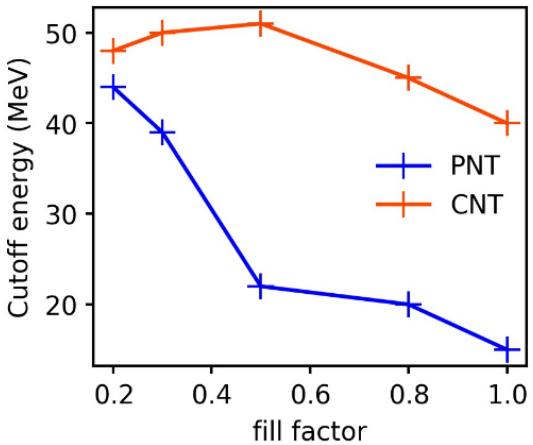
Figure 7. Cutoff energies of protons versus fill factors for the PNT and the CNT.